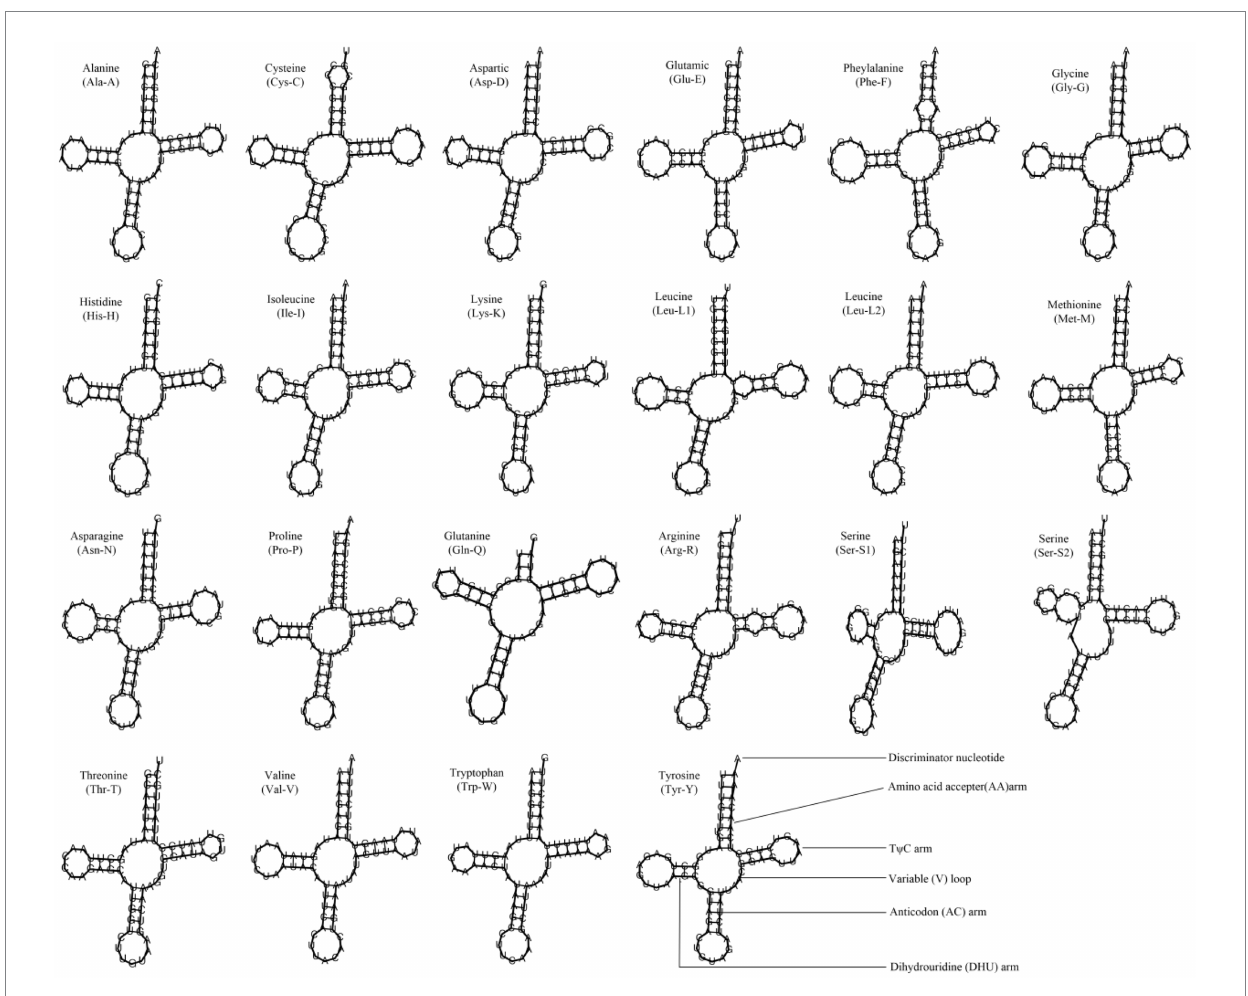
FIGURE 4 Inferred secondary structures of 22 tRNAs from Lyncina